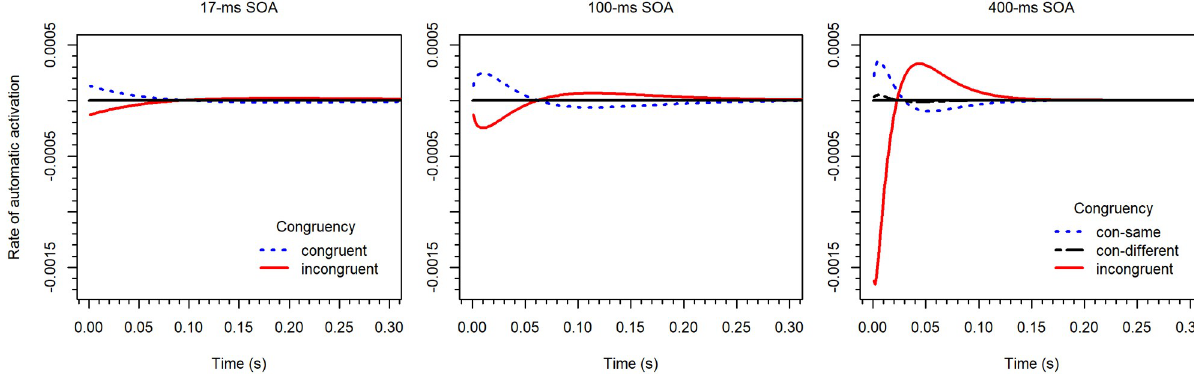
Fig 8. The rate ( μ ( t )/1000) of the automatic process in the DMC model for the 17- ms (top left), the 100- ms (top right), and the 400- ms (bottom) a SOA condition in Experiment 2.